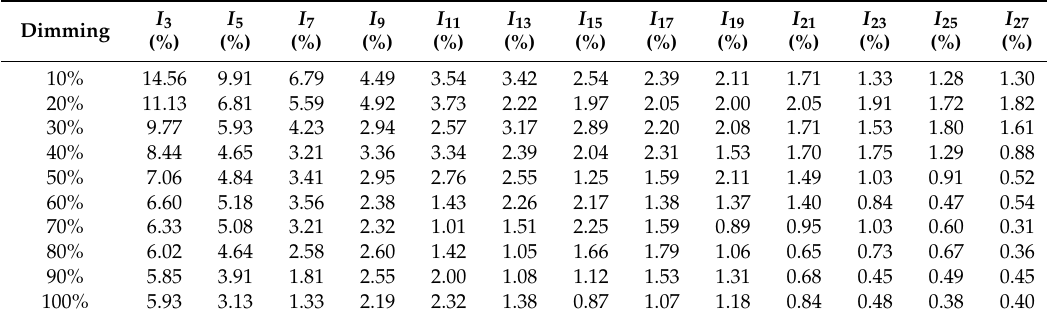
Table 11. Summary of measured values of electrical parameters of the LED4